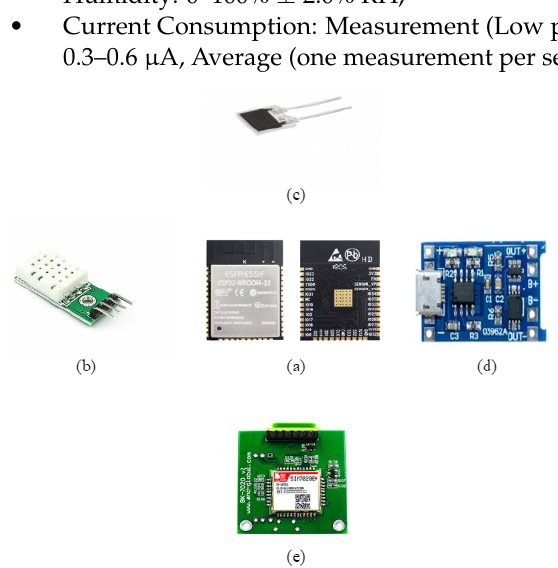
Figure 3. Smart Tag components: ( a ) ESP32-WROOM32 SoC, ( b ) Sensirion SHTC3, ( c ) SAMYOUNG SY-DS-1L, ( d ) TP4056 and ( e ) Simcom